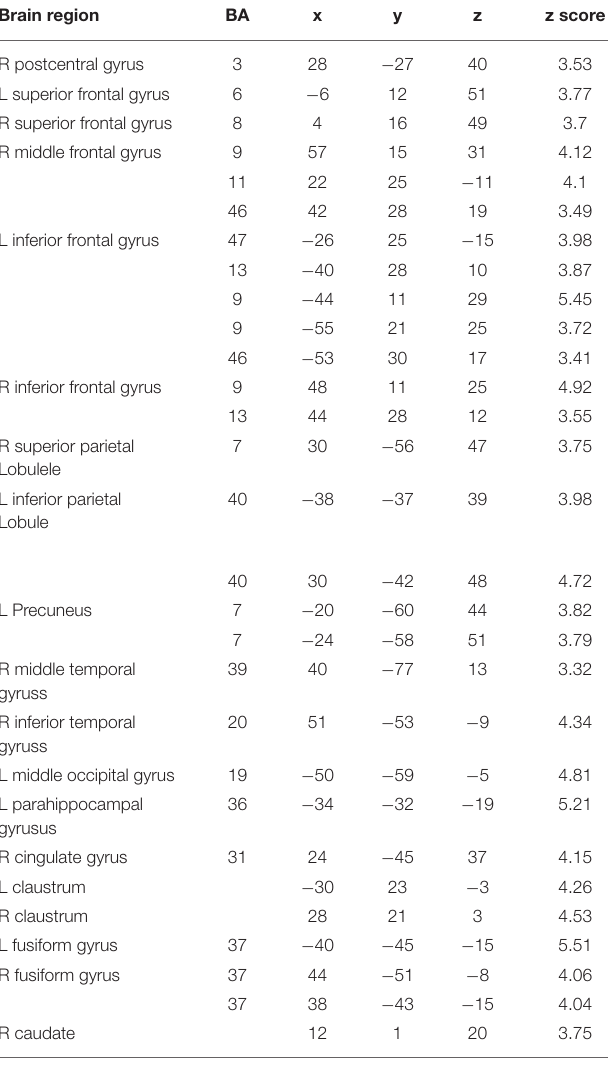
TABLE 1 | Coordinates of activation peaks of the comparisons between writing HFC and writing LFC. Brain region